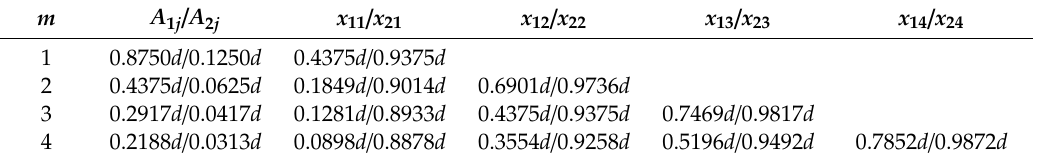
Table 2. The coe ffi cient of integral nodes in the near-ground L 1 and the near-source L 2 . Table 2. The coefficient of integral nodes in the near-ground L 1 and the near-source L 2 .